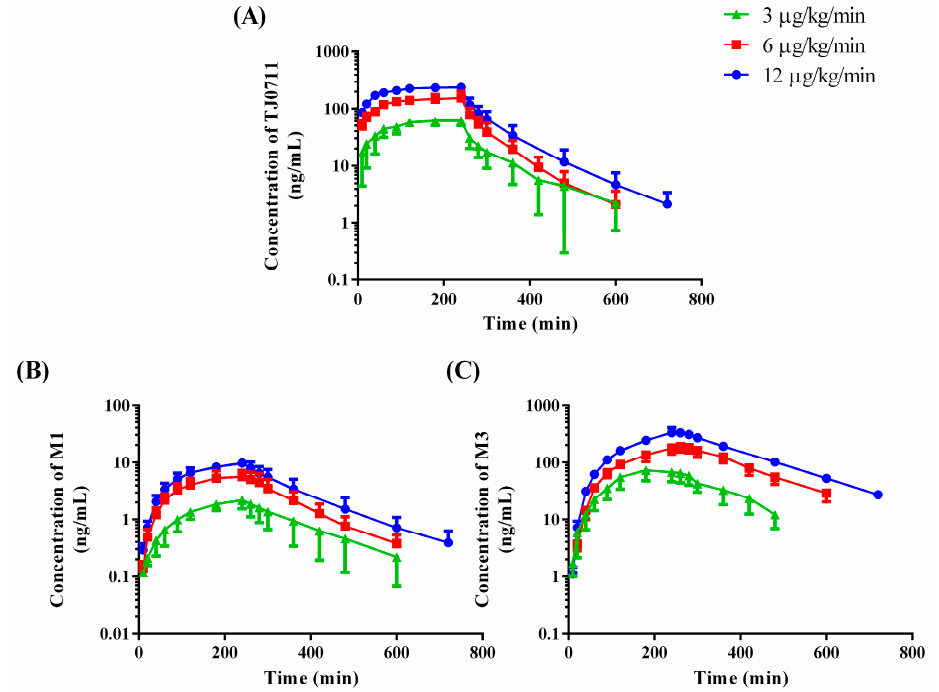
Figure 4. Plasma concentration–time profiles for TJ0711 ( A ), M1 ( B ), and M3 ( C ) in beagle dogs following intravenous infusion of 3, 6, and 12 μ g/kg/min TJ0711 ∙ HCl. Data are represented as mean ± S.D, n = 6.